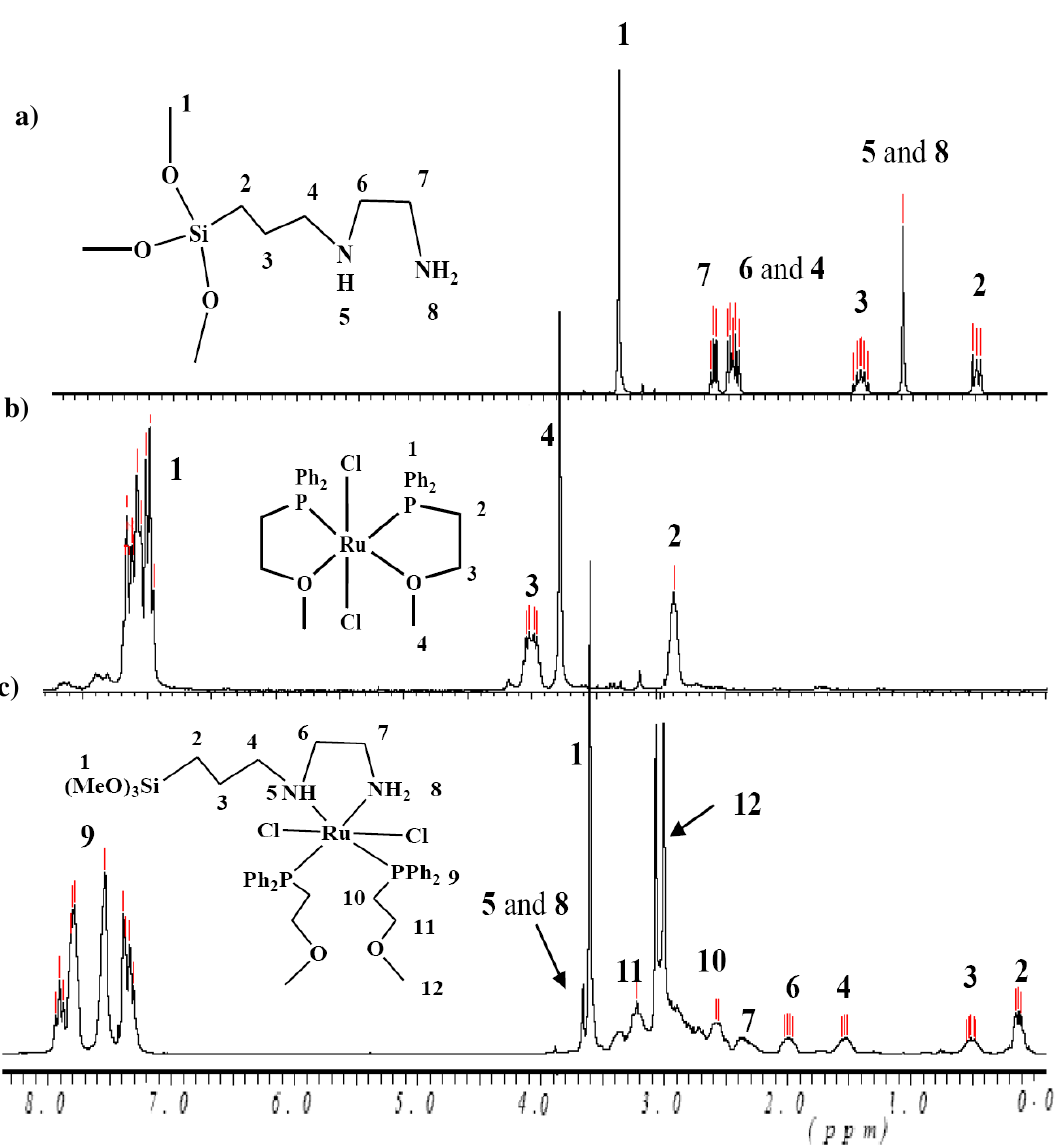
Figure 4. 1 H-NMR of: a) free ligand [3-(2-aminoethyl)aminopropyl]trimethoxysilane;